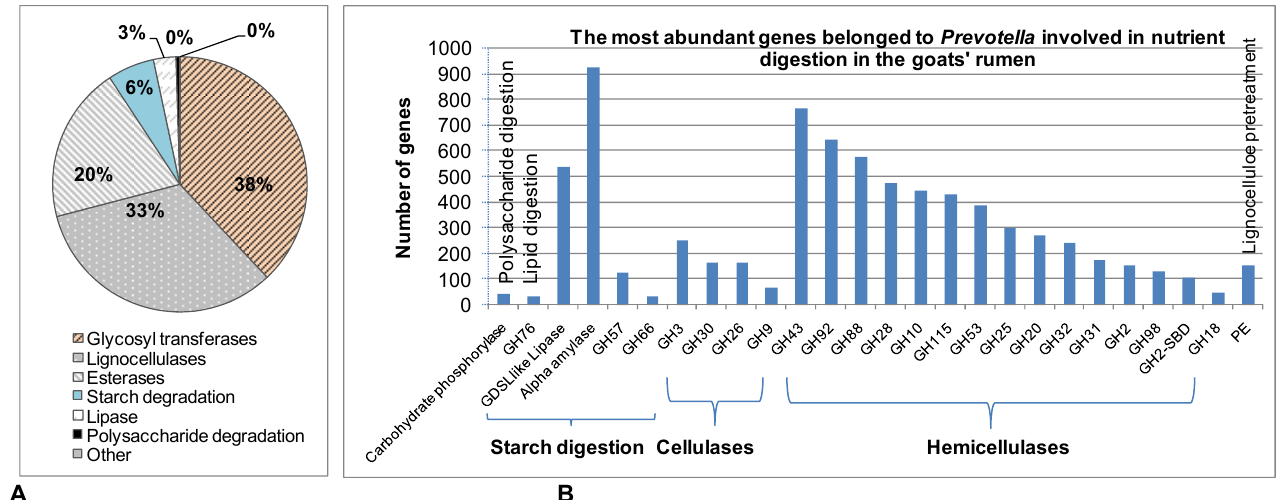
Figure 6. The contribution of Prevotella for digestion of nutrients including protein, lipid, polysaccharide, starch, and lignocellulose in Vietnamese goats’ rumen. ( A ) Percentage distribution of genes coding for enzymes involved in nutrient digestion in total 7670 genes annotated by CAZy and HMMER. ( B ) The richness enzymes related to the digestion of polysaccharide, lipid, starch, and lignocellulose that annotated by CAZy and HMMER.